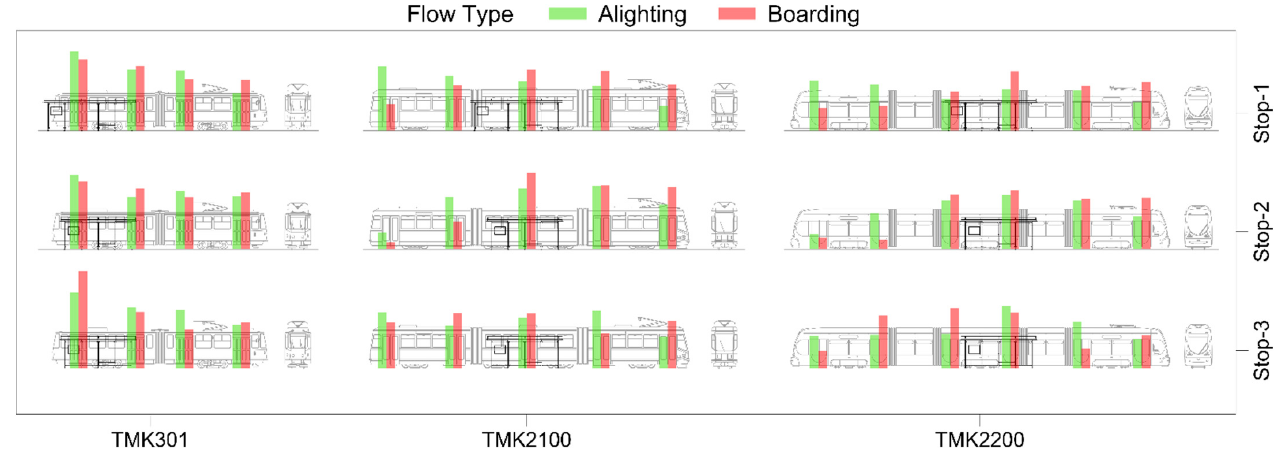
Figure 13. Distribution of passengers alighting and boarding tram vehicles.